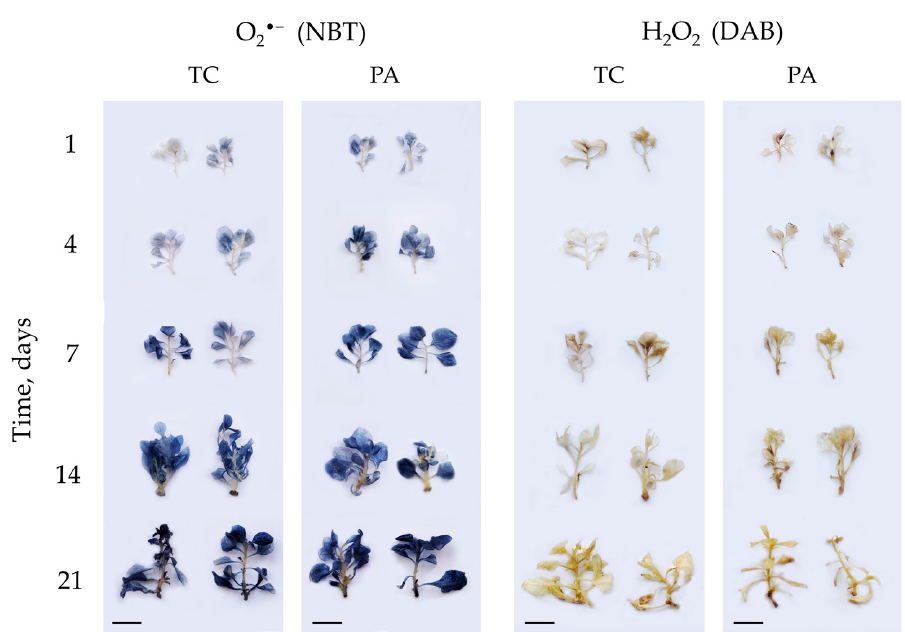
Figure A1. Detection of O 2 •− and H 2 O 2 in tobacco control (TC) and timentin-treated (PA) in vitro shoots using NBT and DAB histochemical staining. Dark blue and brown dye deposits represent O 2 •− and H 2 O 2 accumulation sites, respectively. Representative shoot samples are shown; time is presented as days after shoot transfer to fresh medium; scale bar represents 1 cm.